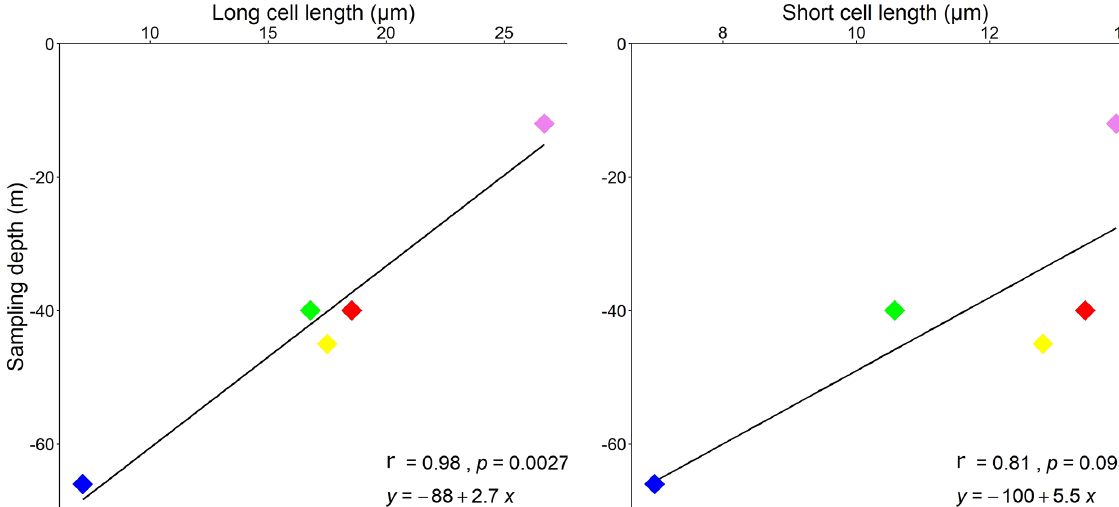
Figure 9. Correlation plots showing the relationship between sampling depth and cell lengths, measured in both long and short cells. Pearson’s correlation significance at p< 0 . 05. Pink is for Morlaix Bay (France, 12); green is for Egadi Islands (Italy, 40); red is for Santa Caterina shoal (Italy, 40); yellow is for Elba island (Italy, 45); blue is for Pontine Islands (Italy,